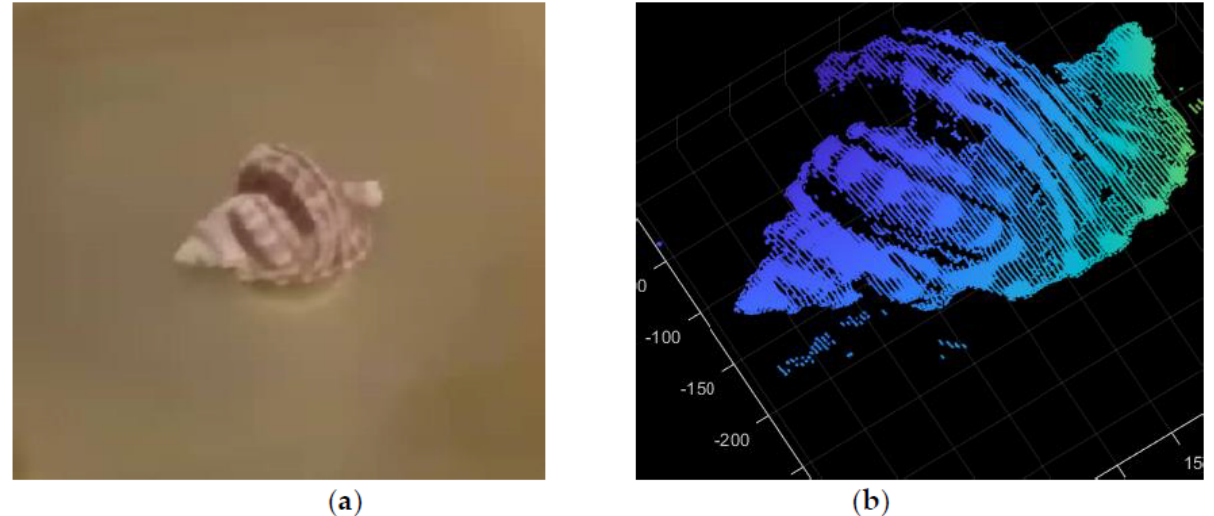
Figure 9. 3D reconstruction results of underwater conch. ( a ) Conch placed in the water; ( b ) 3D point cloud of